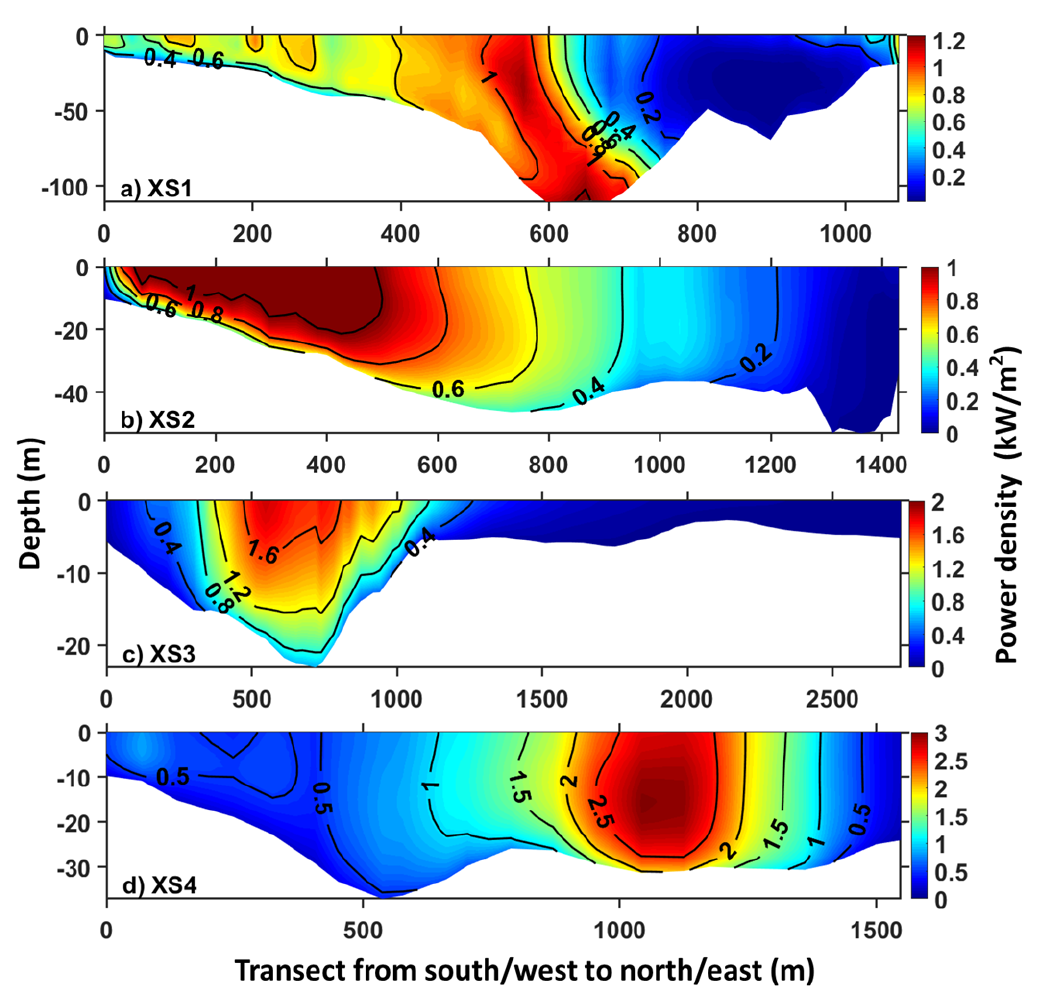
Figure 13. Predicted tidal power density along cross sections ( a ) XS1 and ( b ) XS2 in the Western Passage, ( c ) XS3 in Cobscook Bay, and ( d ) XS4 in Head Harbor Passage. The locations of the cross sections are shown in Figure 1.